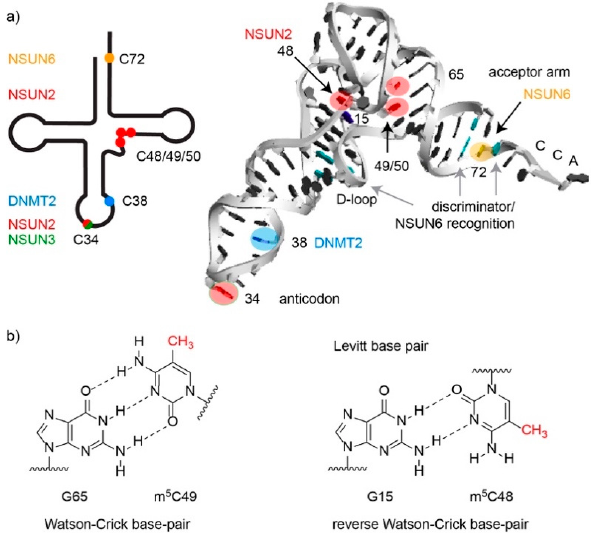
Figure 3. The m 5 C modifications in cytoplasmic and mitochondrial tRNAs. ( a ) Schematic secondary structure and three-dimensional L-shape structure of a tRNA with the positions of m 5 C modifications and the cognate methyltransferases responsible for installing them marked. The interaction sites of NSUN6 with the discriminator base and additional base pairs in the acceptor stem and the D-loop are indicated as observed by X-ray crystallography. ( b ) Chemical structures of m 5 C-containing base pairs in Watson-Crick orientation (with the D-stem G65-m 5 C49) and the reverse-Watson-Crick orientation of the Levitt base pair G15:m 5